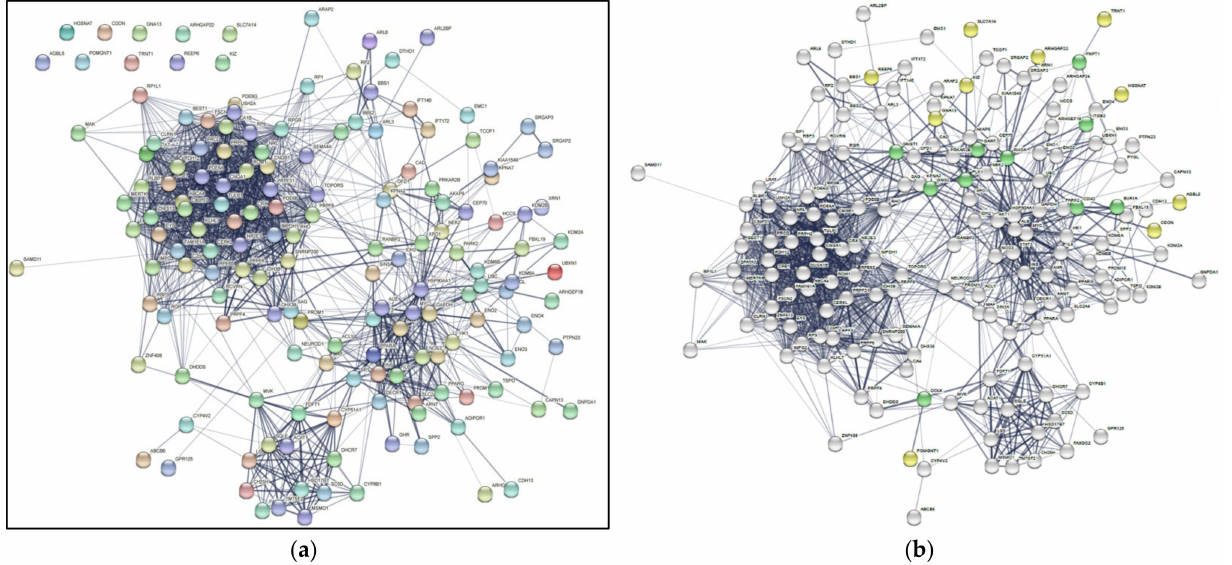
Figure 1. Complex PPI network of RP causal genes. ( a ) The Initial Map of Genes Based on the Protein– Protein Interactions from the STRING v11 Database. The disconnected or isolated genes without any PPI are shown in the top left corner: POMGNT1, REEP6, HGSNAT, CDON, GNA13, ARHGAP22, SLC7A14, AGBL5, TRNT1, KIZ. ( b ) The Color-coded Map of Genes Based on the Protein–Protein Interactions from the STRING v11 Database, including Intermediate genes. This map is the original output downloaded from STRING before the gene classification and automation. The white nodes represent the genes from RetNet that can connect to each other directly. The yellow nodes represent the genes from RetNet that required an intermediate gene to connect to the rest of the map, previously shown to be disconnected in the absence of intermediate genes in Figure 1a. The green nodes are the intermediate genes that were discovered by the